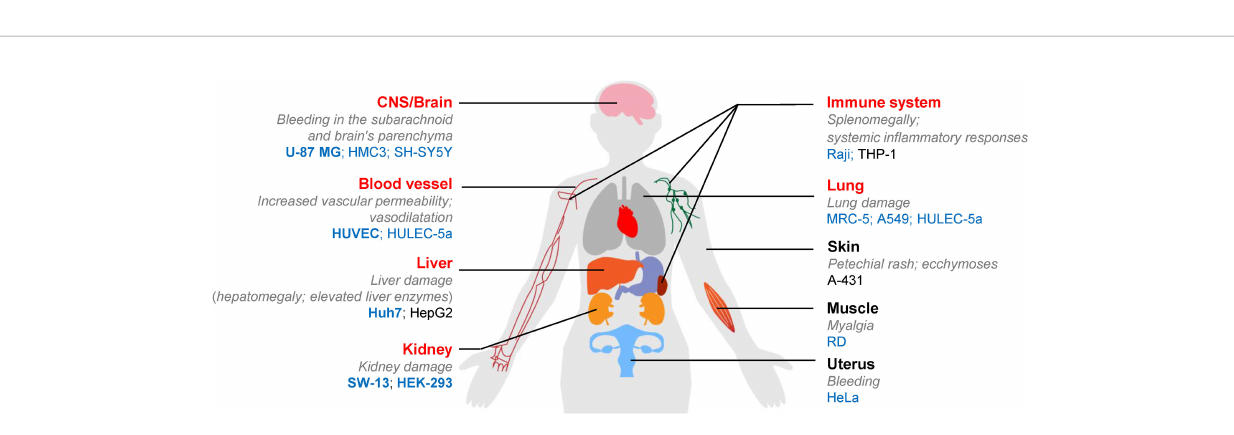
FIGURE 3 | Graphic representation summarizing the correlation between CCHFV susceptibility of human cell lines tested in the current study and tissue origins as well as respective clinical manifestations in human body. The main targeting tissues of CCHFV are indicated in red font as previously reported (Akinci et al., 2013; Ozsoy et al., 2015). The main clinical manifestations in the organs or systems are presented in grey italics. CCHFV-permissive human cell lines were indicated by blue font as de fi ned in our current study. The fi ve cell lines (U-87 MG, HUVEC, Huh7, HEK293 and SW-13) of high susceptibility to CCHFV as suggested for the use of ex vivo fundamental studies are highlighted in bold. Non-permissive cell lines are shown in